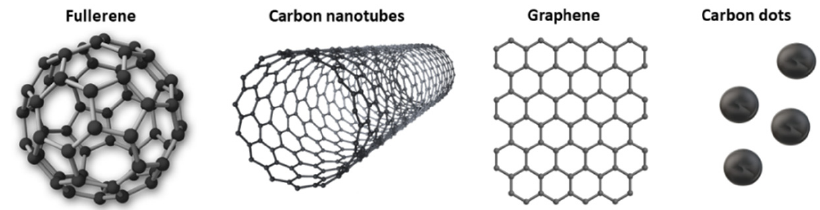
Figure 7. Carbon nanomaterial types that can be used for MNC production.